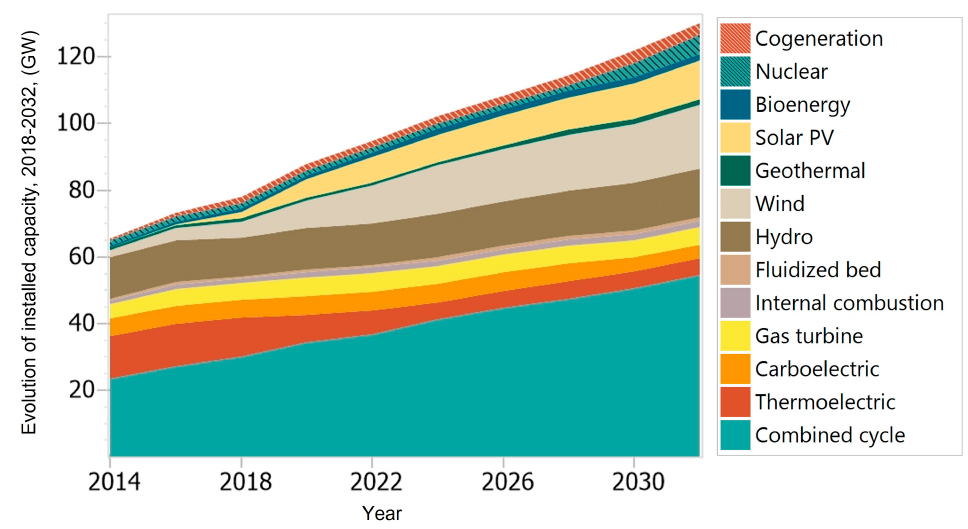
Figure 3. 2014 to 2032 Mexican Installed capacity. Source: own elaboration with information from [7].